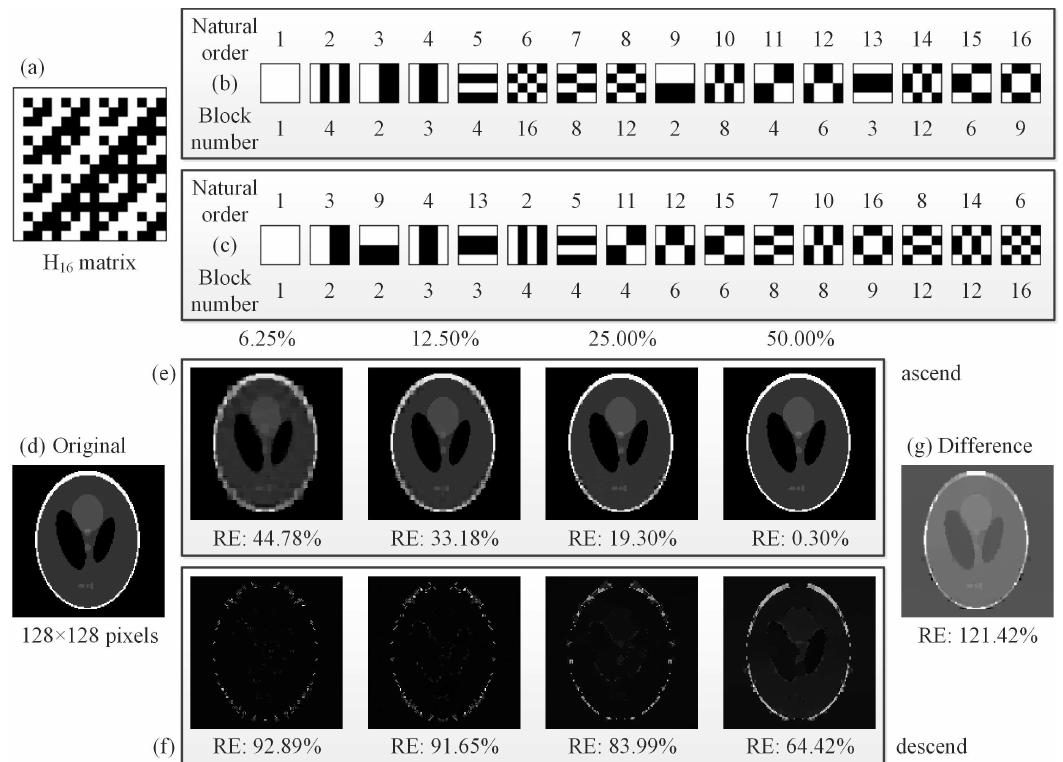
Figure 2. An example for the “cake-cutting” Hadamard basis: ( a ) a 16 × 16 Hadamard matrix H 16 ; ( b ) the basis patterns of H 16 in the natural order; ( c ) the basis patterns of H 16 in our optimized “cake-cutting” order; ( d ) an original head phantom image of 128 × 128 pixels; ( e , f ) comparison of CS reconstructions with the first 6.25%, 12.50%, 25.00% and 50.00% of the fully sampled measurements while the piece numbers are in their ascending order and descending order, respectively; and ( g ) the difference image of the fourth images of ( e , f